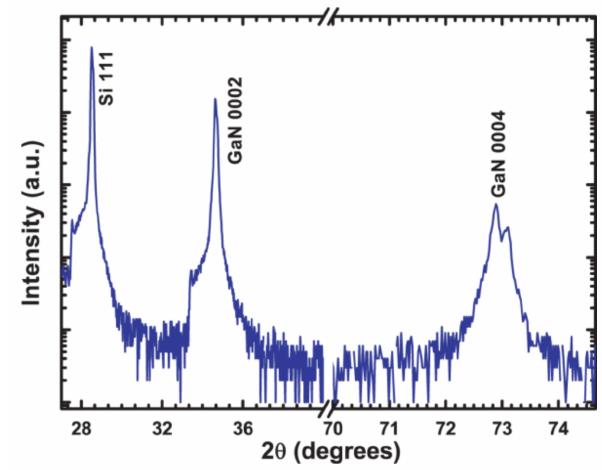
Figure 3. XRD θ /2 θ scans from the sample grown at P N2 = 4.5